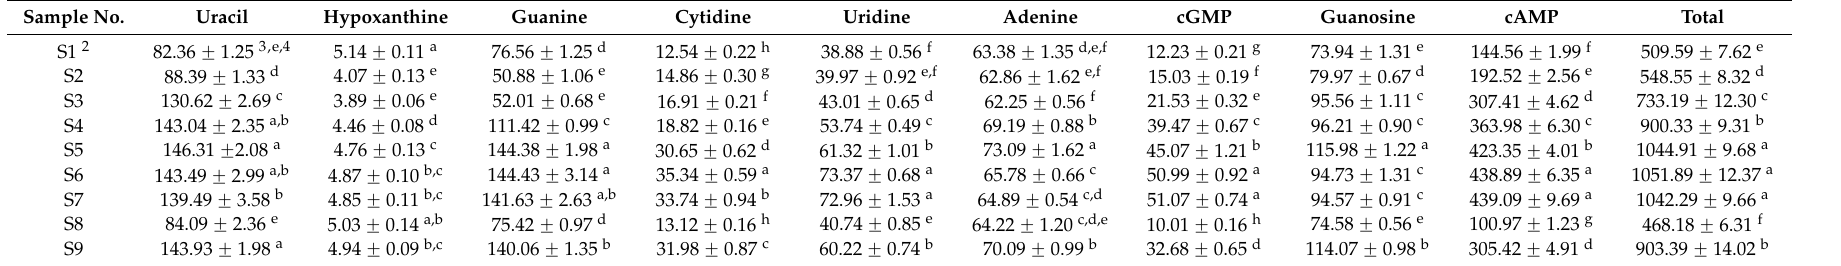
Table 3. The analysis results of nucleosides and nucleobases in the samples ( µ g/g, DW 1 , n = 3). Sample